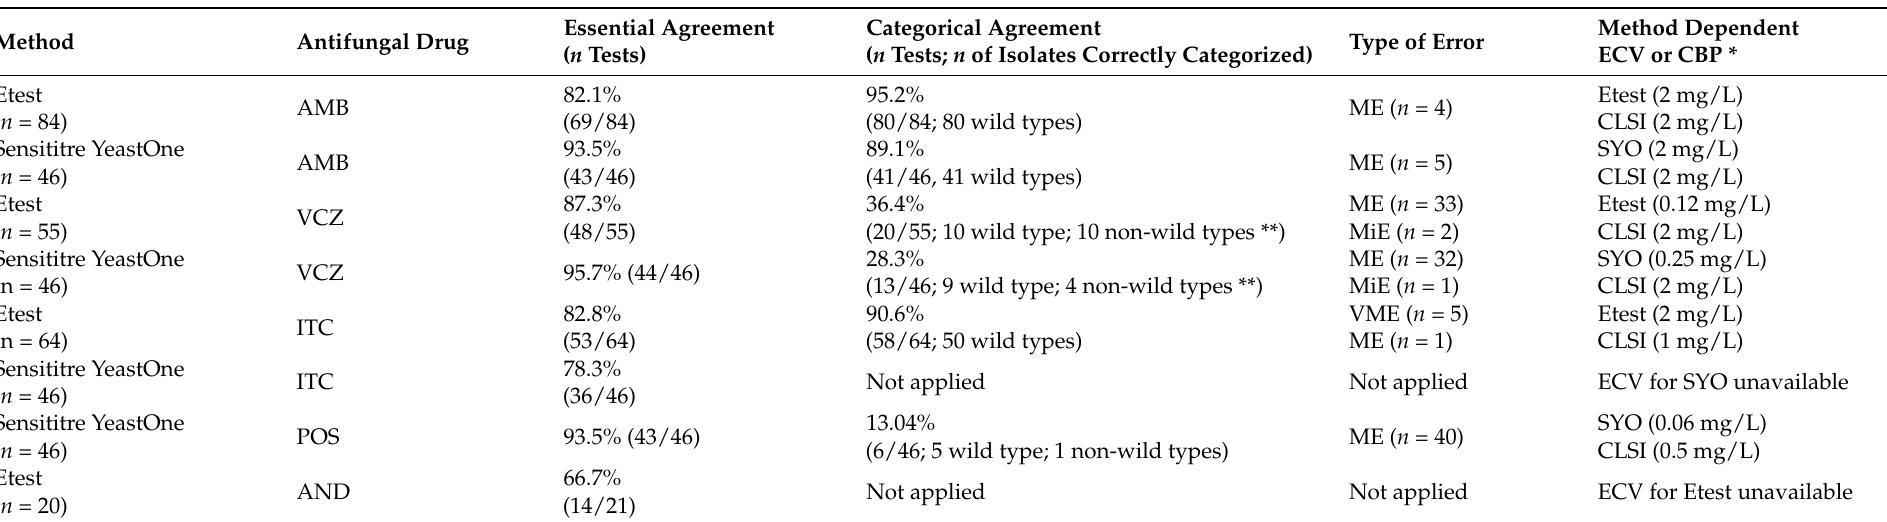
Table 3. Essential agreement and categorical agreement of Etest and Sensititre YeastOne methods, compared with CLSI-M38 method, according to the